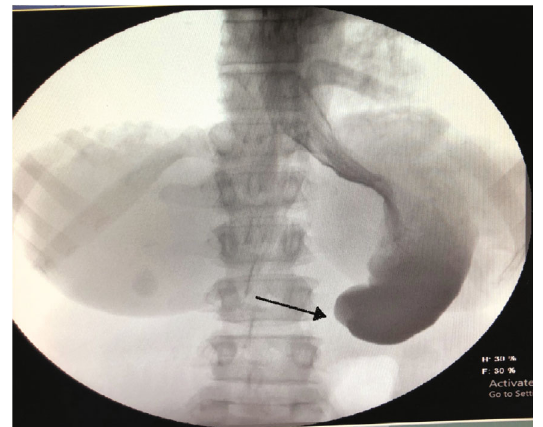
Figure 1: Gastrogra fi n swallow study showing gastric outlet obstruction with mild gastroesophageal re fl ux as seen on fl